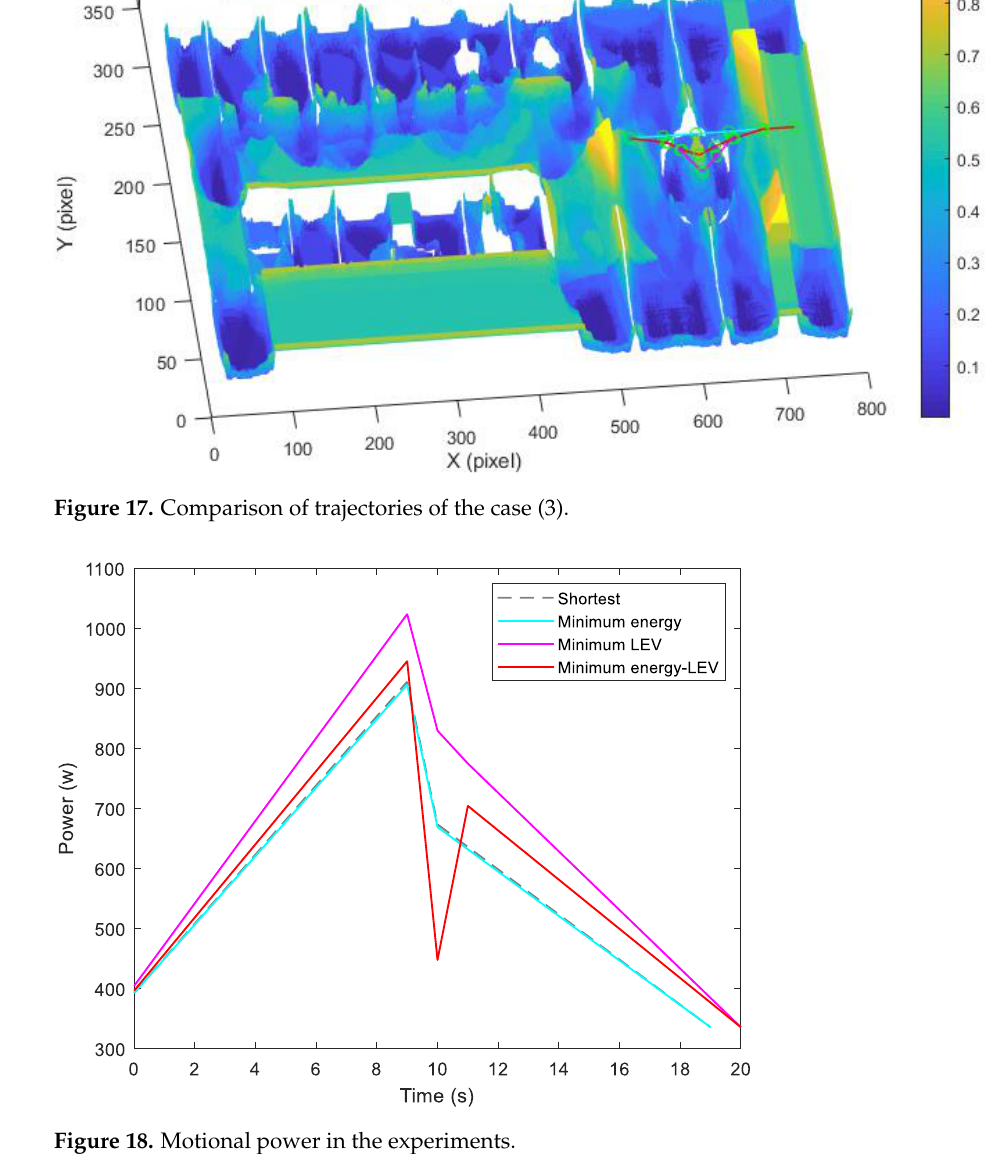
Figure 18. Motional power in the experiments.